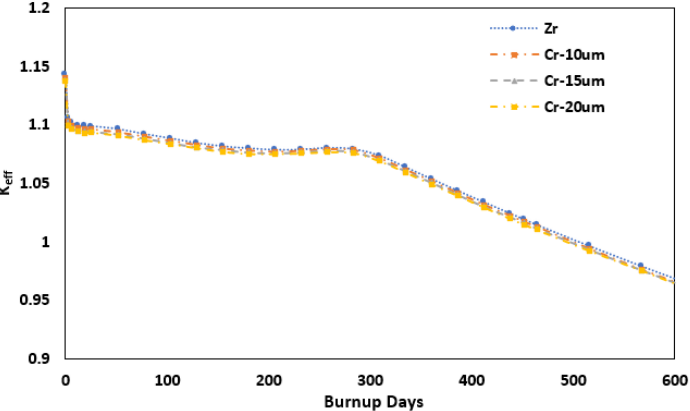
Figure 10. LWR accident evolution scenario for reference cladding and ATF cladding [2].